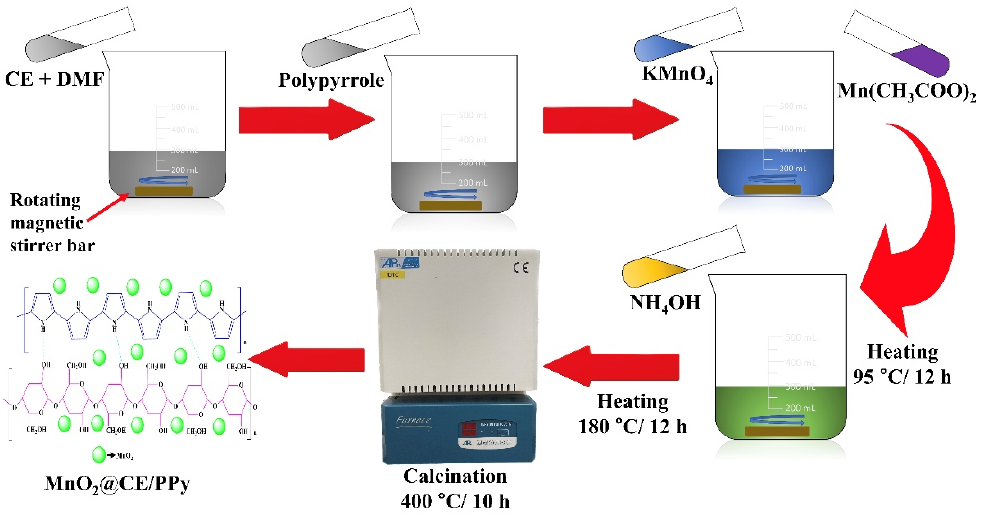
Figure 2. Fabrication process of MnO 2 @CE/PPy.